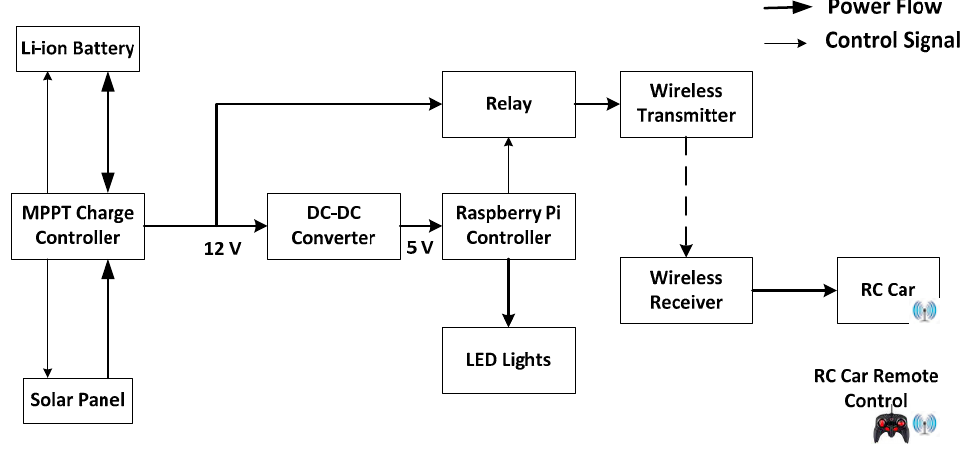
Figure 1. System Connection for the Solar Microgrid.